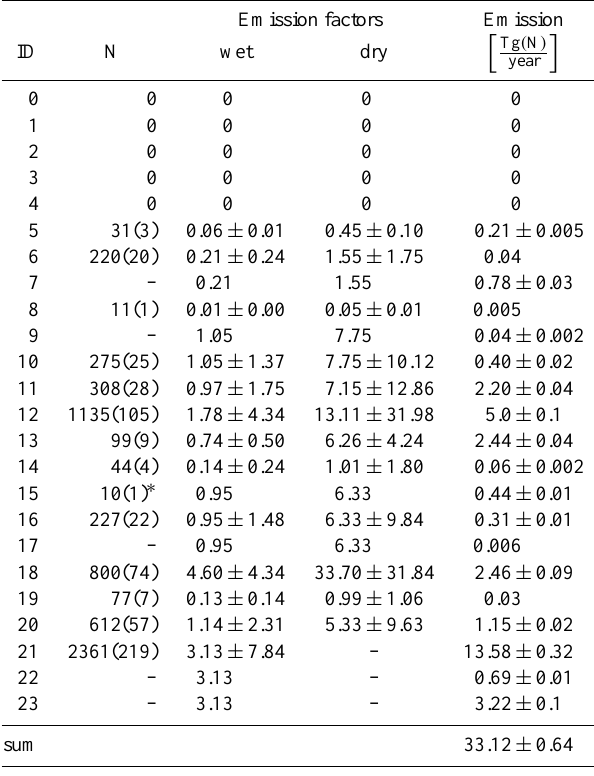
Table 6. The adopted (YL95/SL11) emission factors (arithmetic mean) and associated soil biogenic NO